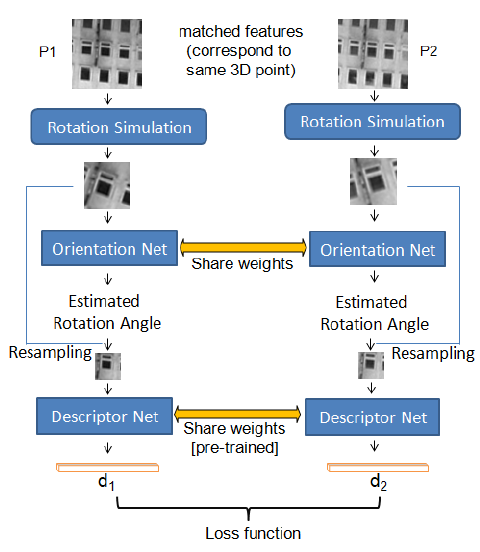
Figure 5. Orientation estimation network architecture. After rota- tion simulation, the rotation angle of simulated patches are estimated and then the patches are resampled using the estimated rotation angle. The resampled patches are subsequently used as input to the pre-trained descriptor network to obtain descriptors 𝑑 1 , 𝑑 2 and the loss.